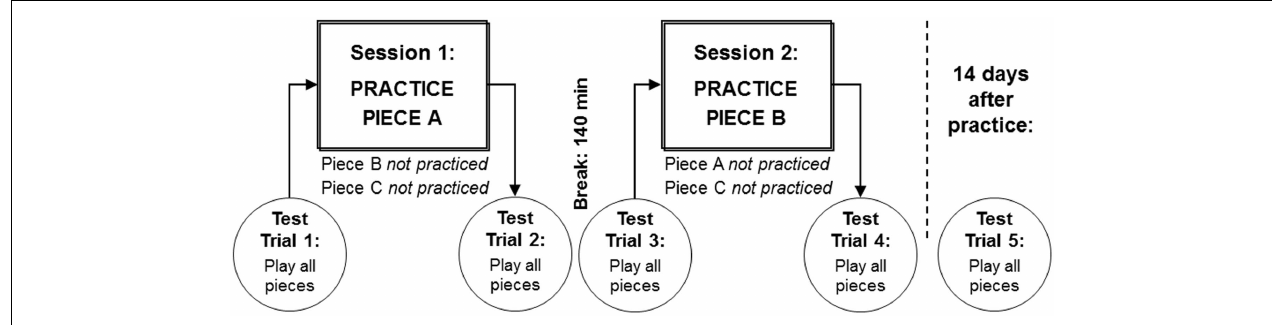
FIGURE 2 |Two practice sessions were conducted during the same day, in which LSJ practiced two pieces on the viola . Piece A was practiced in Session 1, and Piece B in Session 2. LSJ’s performance on all pieces was evaluated at a tempo of 144bpm in test trials before and after each practice session, and 14days after